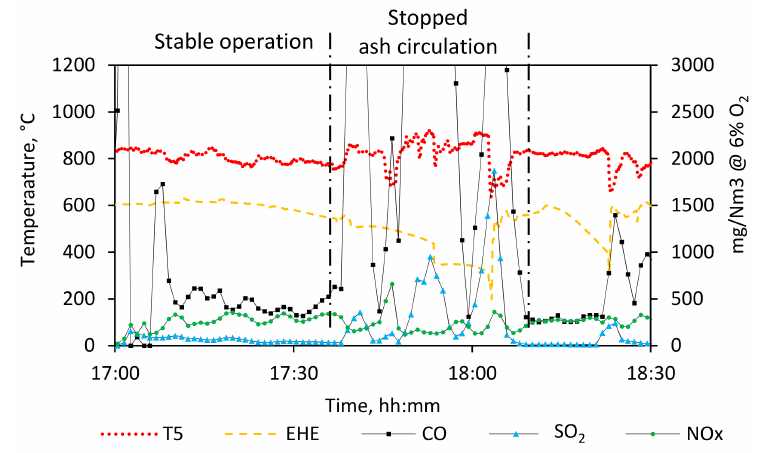
Figure 3. Pollutant emissions during oil shale CFB and fluidized bed combustion.